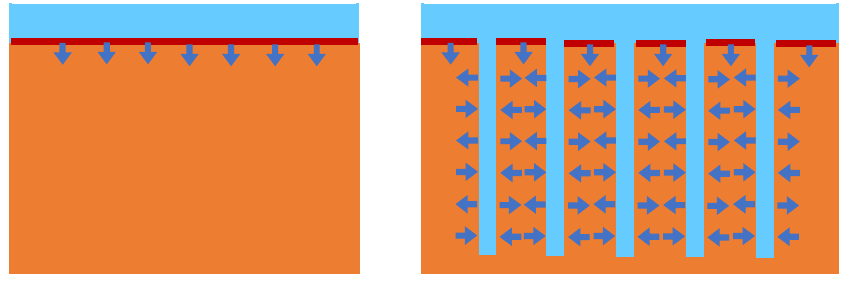
Figure 12. The pattern of the salt supply to the soil.